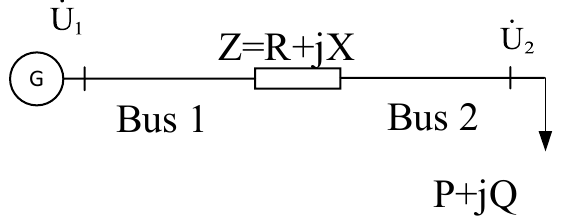
Figure 2. Single generator and single load system.